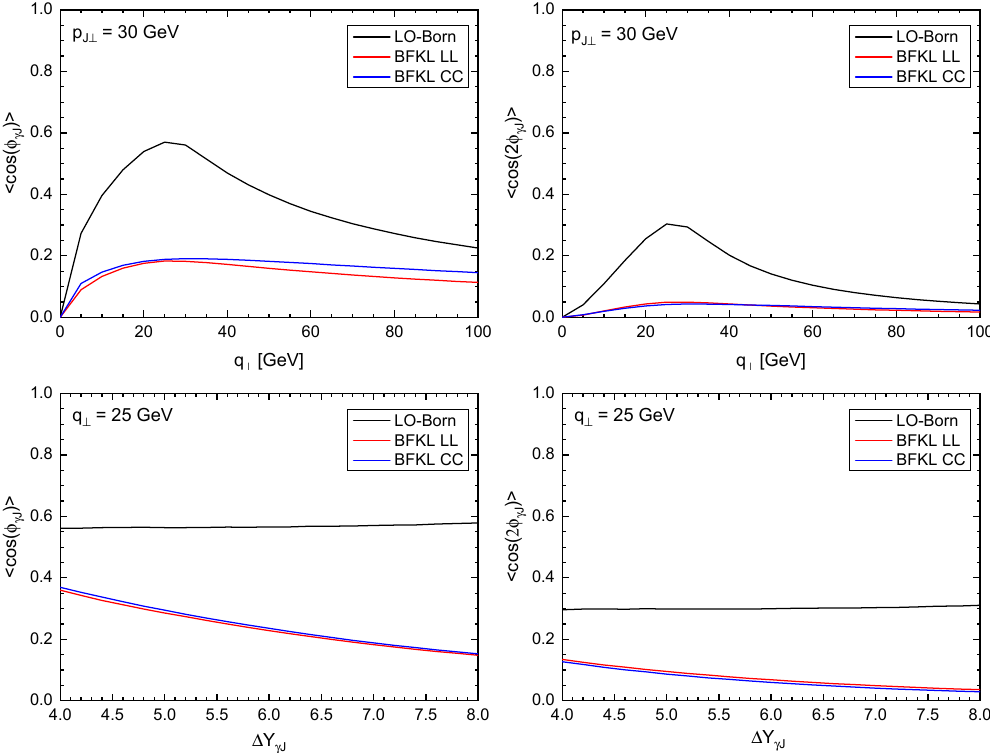
Figure 4 . The mean cosine h cos( n(cid:30) (cid:13)J ) i for n = 1 (left) and n = 2 (right) as a function of the photon momentum q ? (upper row) and the photon-jet rapidity di(cid:11)erence (cid:1) Y (cid:13)J (lower row). We choose (cid:1) Y (cid:13)J = 7 for the upper plots and q ? = 25 GeV for the lower plots. The jet momentum p J ? = 30 GeV and the invariant mass of photon-jet system M = 35 GeV in all cases. (cid:30) , the mean cosine in the BFKL case is given (cid:13)J